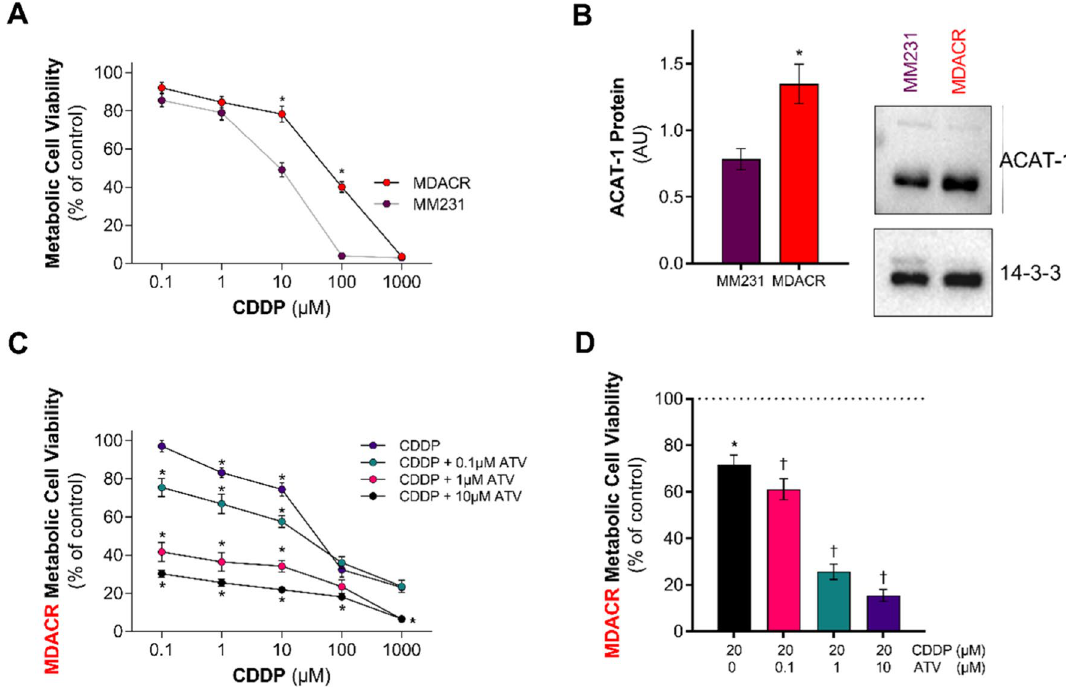
Fig. 7 Effect of combined treatment with CDDP plus ATV on MDACR cells. A MDACR and MDA-MB-231 (MM231) metabolic cell viability determined by MTT following culturing in media containing CDDP for 48 h. B Representative immunoblots and densitometric quantitation of ACAT-1 in MDA-MB-231 and MDACR cells. ( C ) MDACR cell viability following culturing media containing CDDP alone (ranging from 0.1µM to 1mM) or with ATV (0.1, 1 or 10 µM) for 48 h. Data were normalized to 0.1 µM CDDP only group. (D) MDACR cell viability following cultur- ing in media containing 20 µM CDDP alone or in combination with ATV (0.1, 1 or 10 µM) for 48 h. The data was expressed as percentage of treated cells viability compared to untreated cells (Control). Control cell viability represented by horizontal dashed line indicating 100% cell viability. Data are mean ± SEM at least three independent experiments performed in triplicate ( B ) or quadruplicate ( A , C & D ). *p < 0.05 vs. MDA-MB-231 cells by two-way ANOVA followed by Šídák’s post hoc test ( A ) or by unpaired Student’s t-test (B). *p < 0.05 vs. 0.1 µM CDDP only cells by one-way ANOVA followed by Tukey’s post hoc test ( C ). *p < 0.05 vs. untreated cells (Control), †p < 0.05 vs. 20 µM CDDP treated cells by one-way ANOVA followed by Tukey’s post hoc test ( D